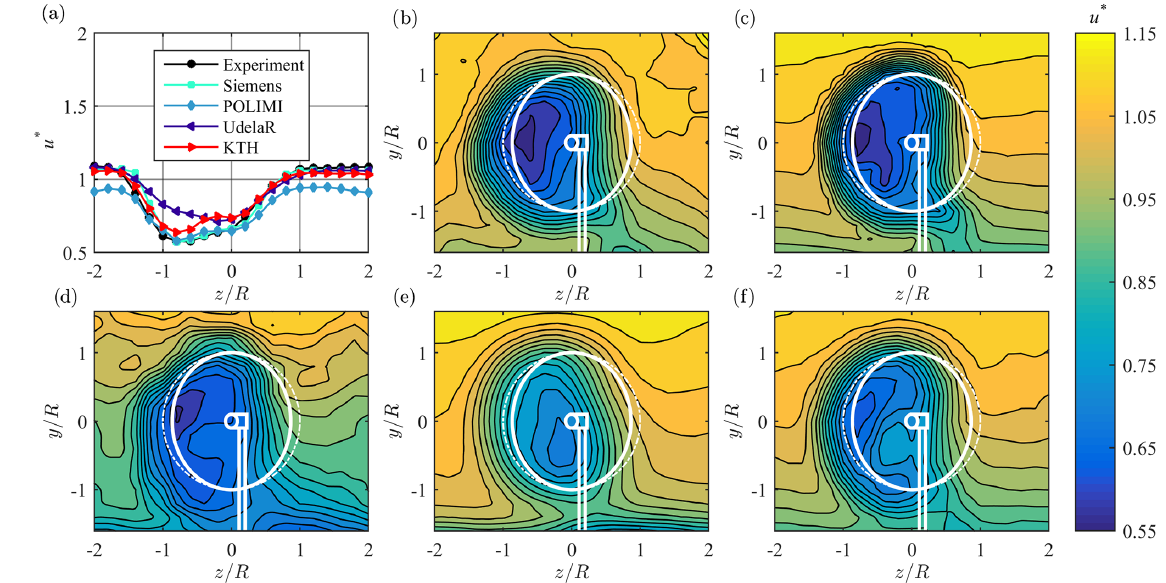
Figure 7. (a) Line plot at hub height and (b–f) contour plots for normalized streamwise mean velocity u ∗ in the wake 3 D behind turbine LARS1, from (b) experiments, (c) Siemens, (d) POLIMI, (e) UdelaR, and (f) KTH. The white lines represent the turbine rotor, nacelle, and tower; solid lines γ = 30 ◦ ; dashed lines γ = 0 ◦ .